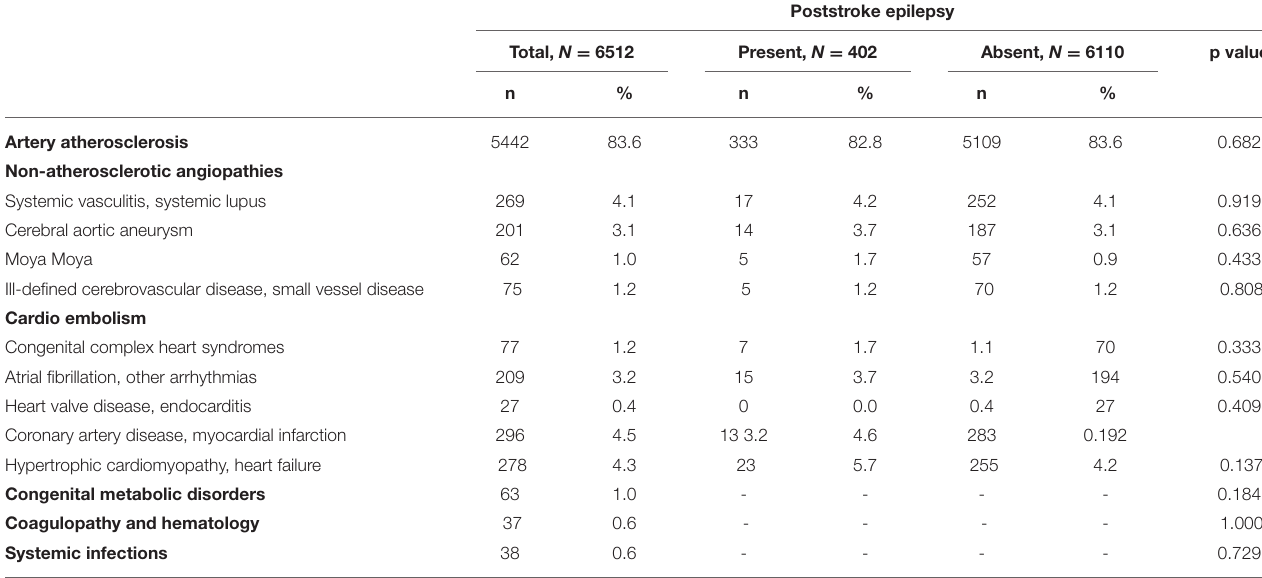
TABLE 2 | Etiology of ischemic stroke and PSE